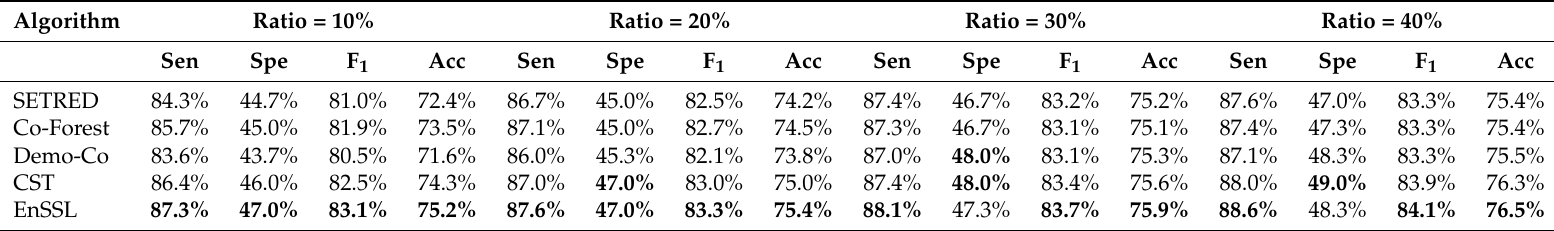
Table 8. Performance evaluation of SETRED, Co-Forest, Democratic-Co learning, CST-Voting and EnSSL on the German credit